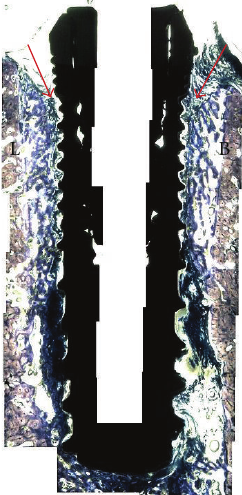
Figure 3: Merged optical micrograph depicting the control group, where the immediate implant placed at the mesial molar socket was not covered with a resorbable membrane prior to suturing. For this group, apical migration (arrows) occurred at both buccal (B) and lingual (L) aspects resulting in lower bone insertion levels along the length of the